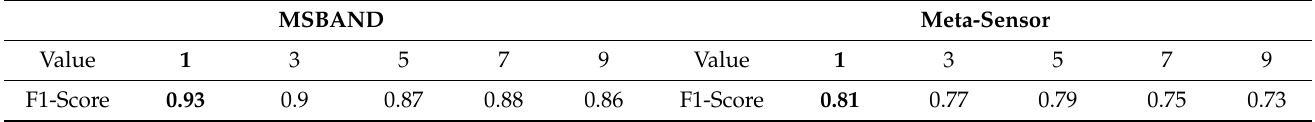
Table 2. Step_Size tuning for MSBAND and meta-sensor datasets, respectively.